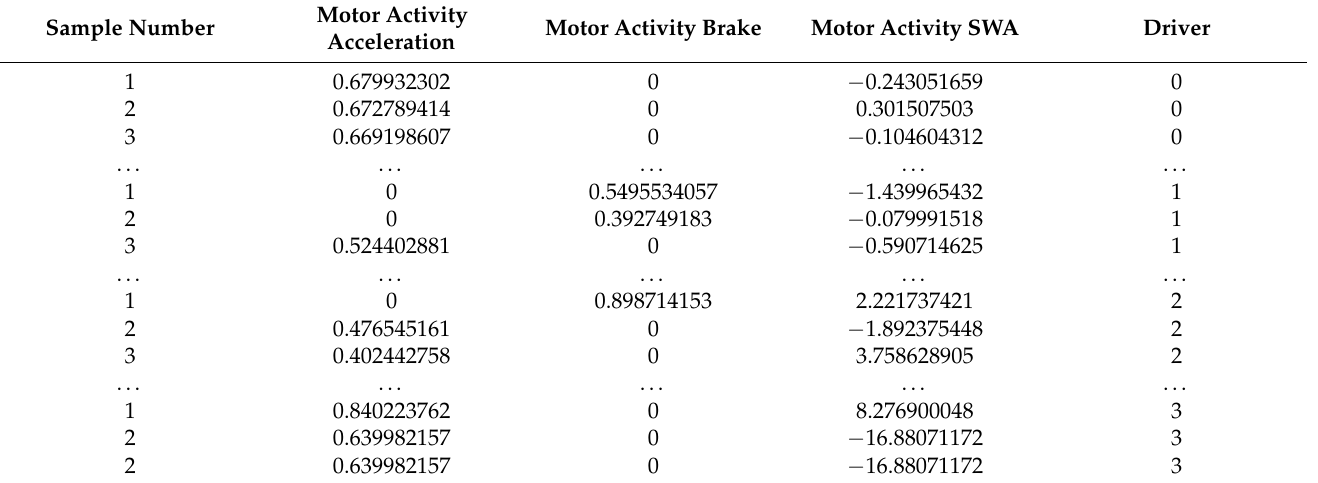
Table 1. Example of generating data by each driver from sensors of the CARLA